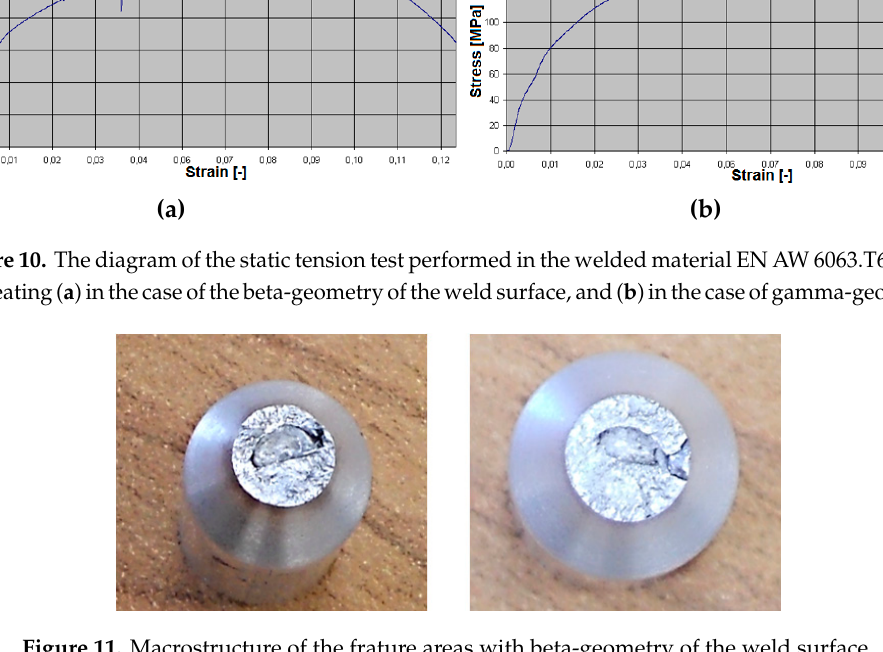
Figure 11. Macrostructure of the frature areas with beta-geometry of the weld surface.